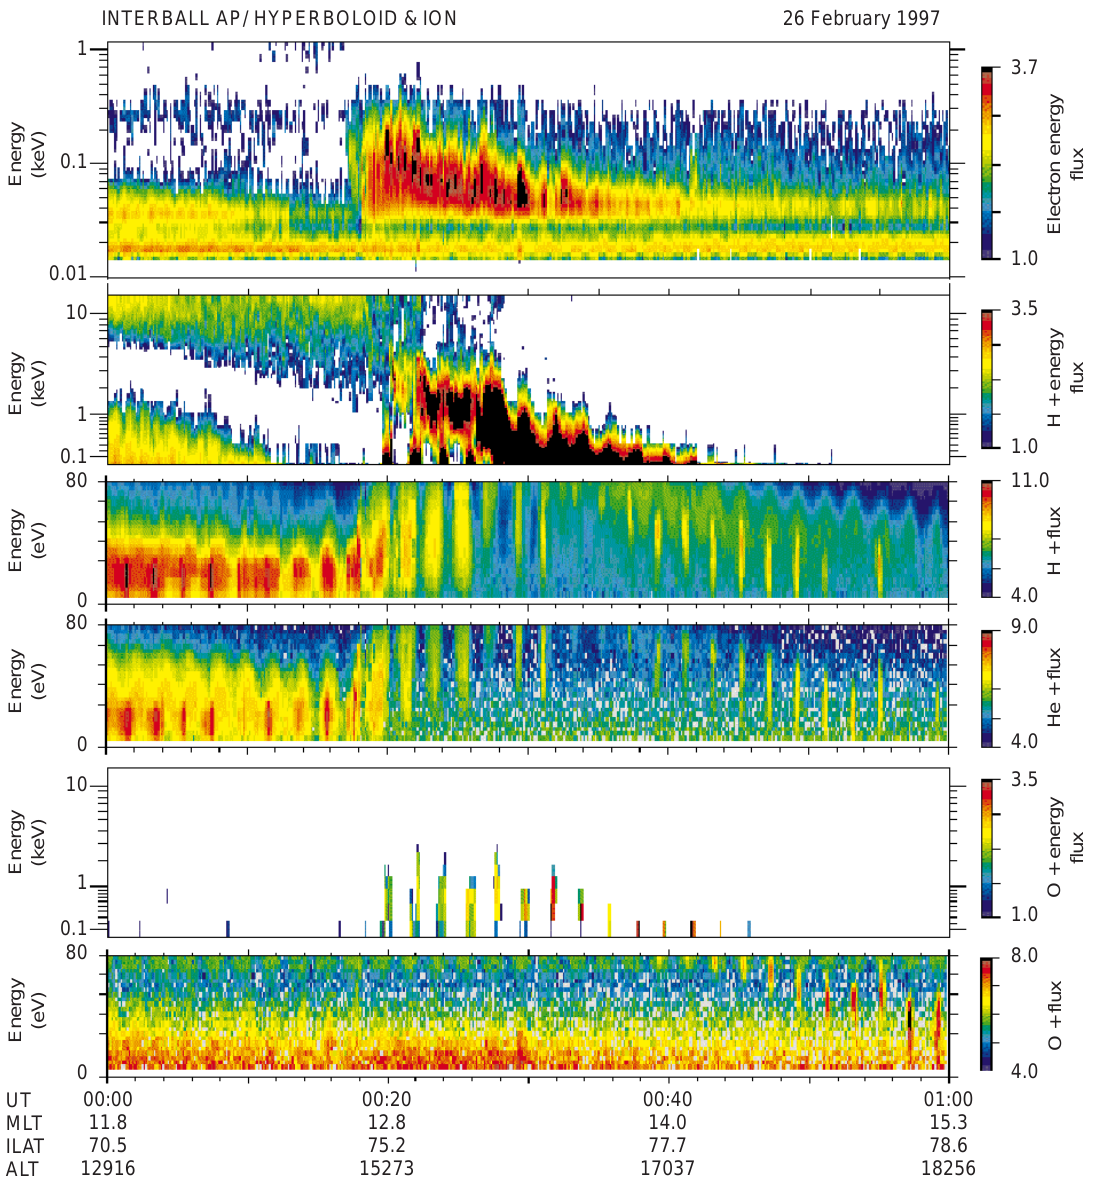
Fig. 8. Energy-time spectrograms of particles during a cusp crossing on 26 February 1997. From top to bottom, 10 eV–1 keV electrons, 100 eV–14 keV H + ions, 0–80 eV H + ions, 0–80 eV He + ions, 100 eV–14 keV O + ions, and 0–80 eV O + ions. High-energy